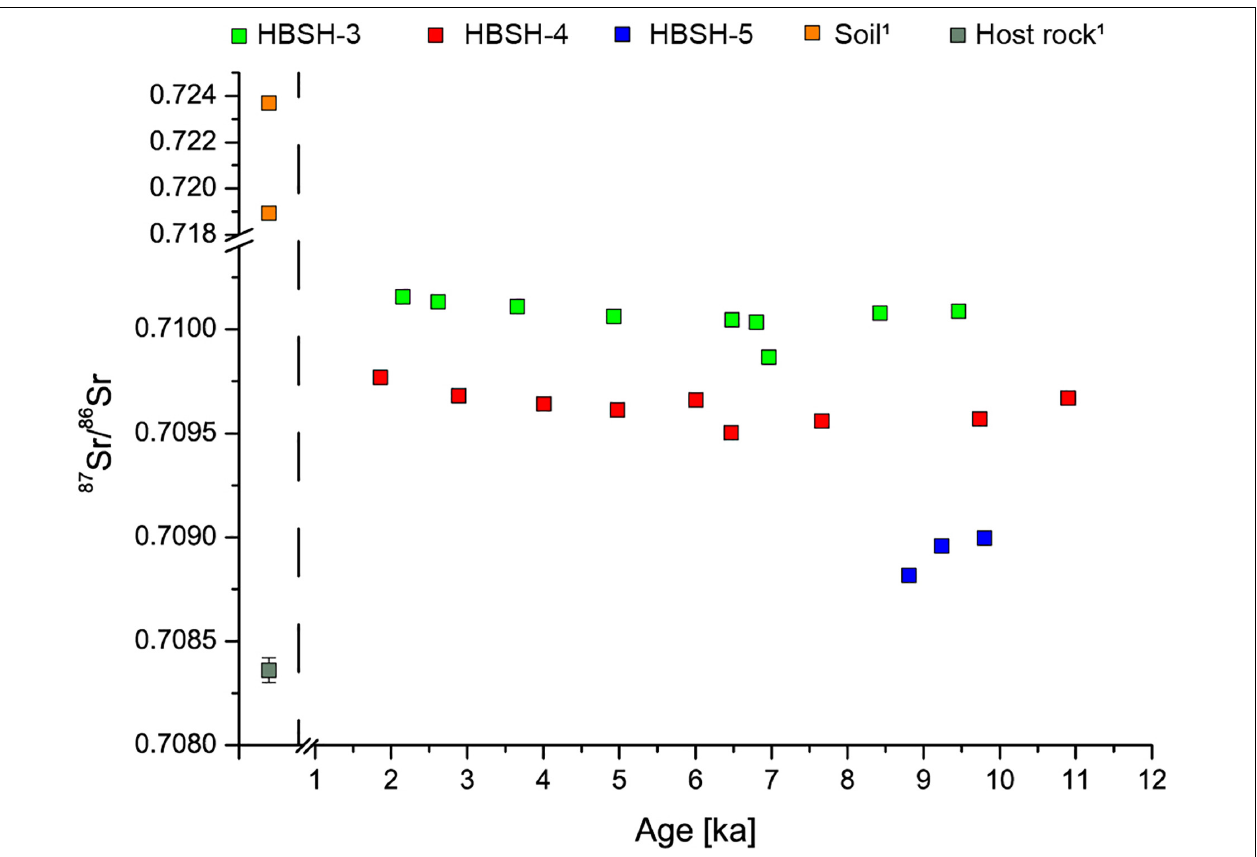
FIGURE 6 | Strontium isotope results for HBSH-3 (green), HBSH-4 (red), and HBSH-5 (blue). 1 Sr isotope values from the host rock and overlying soil at the nearby Bunker Cave (Weber et al., 2018a). Note that analytical uncertainties are usually smaller than the plot symbols.